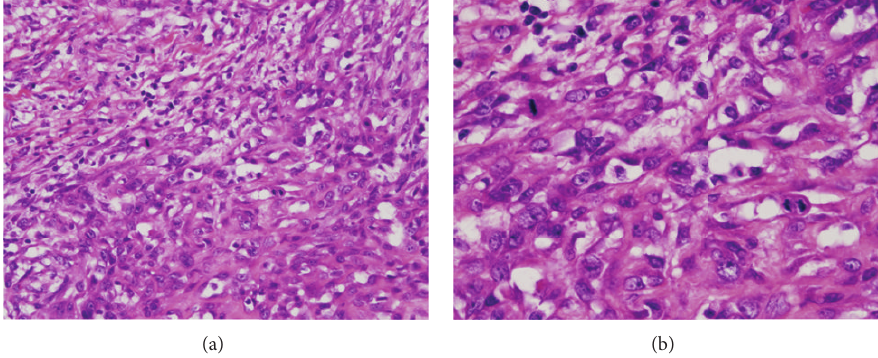
Figure 1: (a) Microscopic examination of primary breast tumor showing invasive proliferation of spindle-shaped and small rhombus cells and showed alveolar formations in a part of the tumor (H&E, × 200). (b) Moderate nuclear pleomorphism, size differentiation, and mitotic figures were seen (H&E, ×